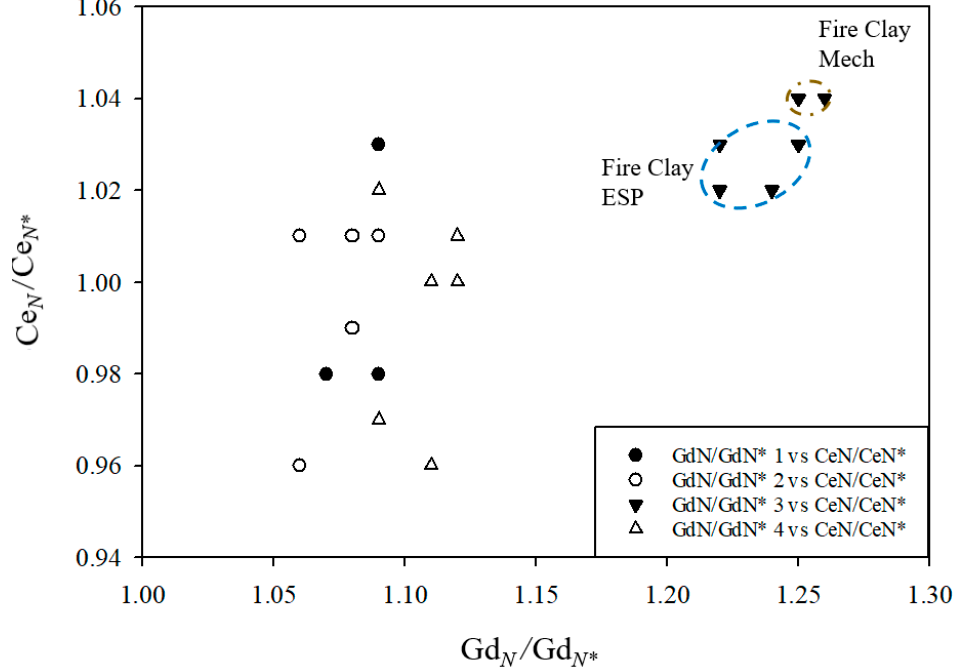
Figure 7. Ce N /Ce N * vs. Gd N /Gd N * for all of the samples.